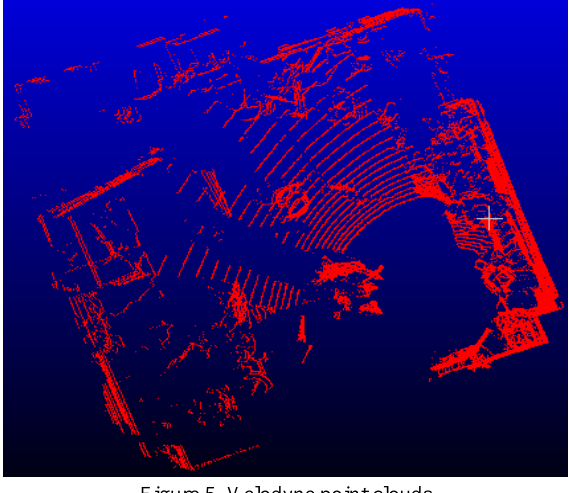
Figure 5. Velodyne point